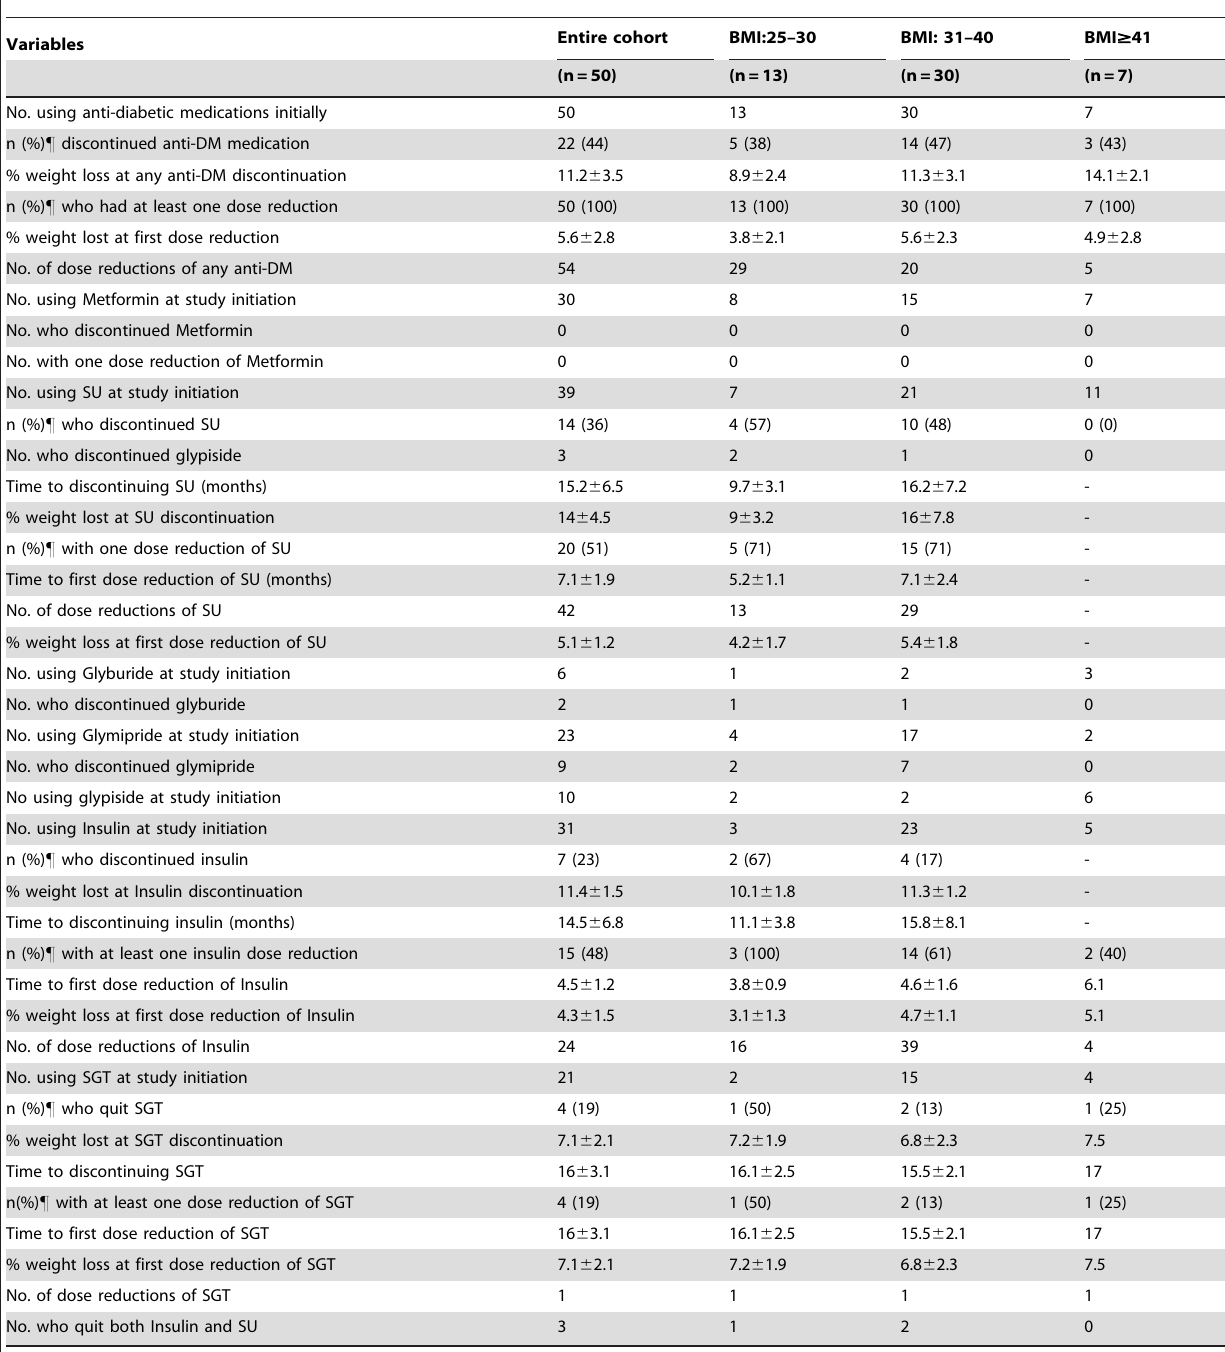
Table 4. Weight loss and details of anti-diabetes drug dose reduction/discontinuation.